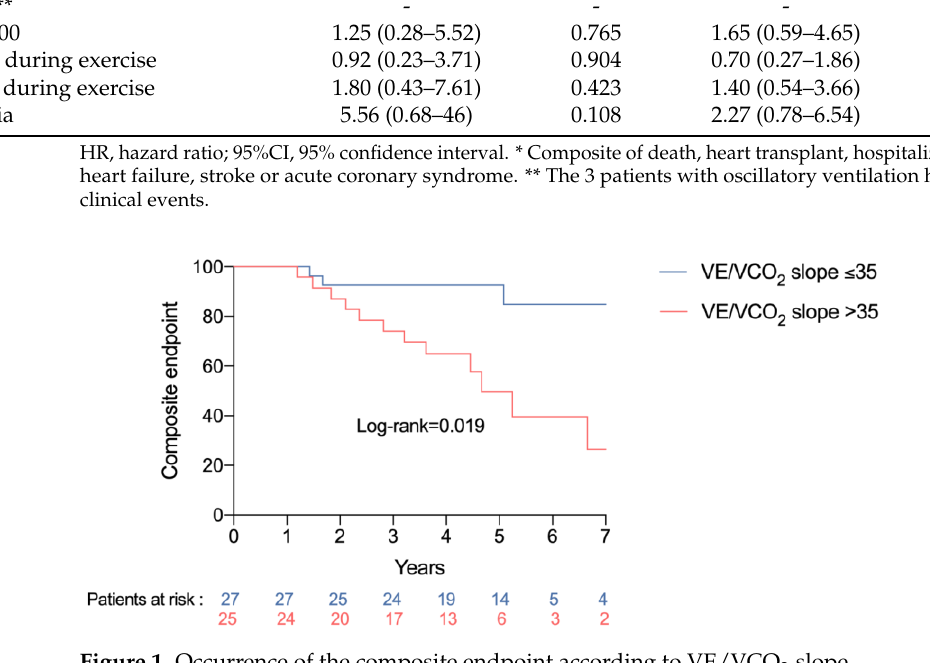
Figure 1. Occurrence of the composite endpoint according to VE/VCO2 slope.